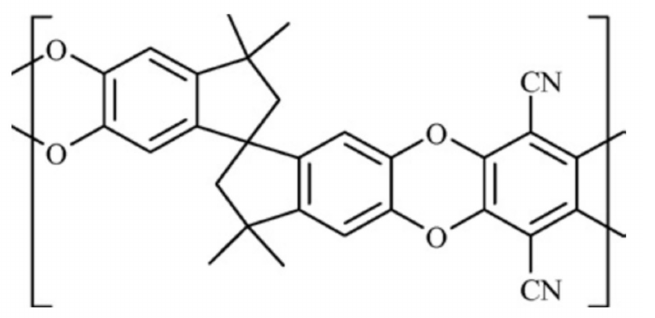
Figure 1. Structures of PIM-1 polymer. The detailed discussion of polymers with intrinsic porosity may be found in